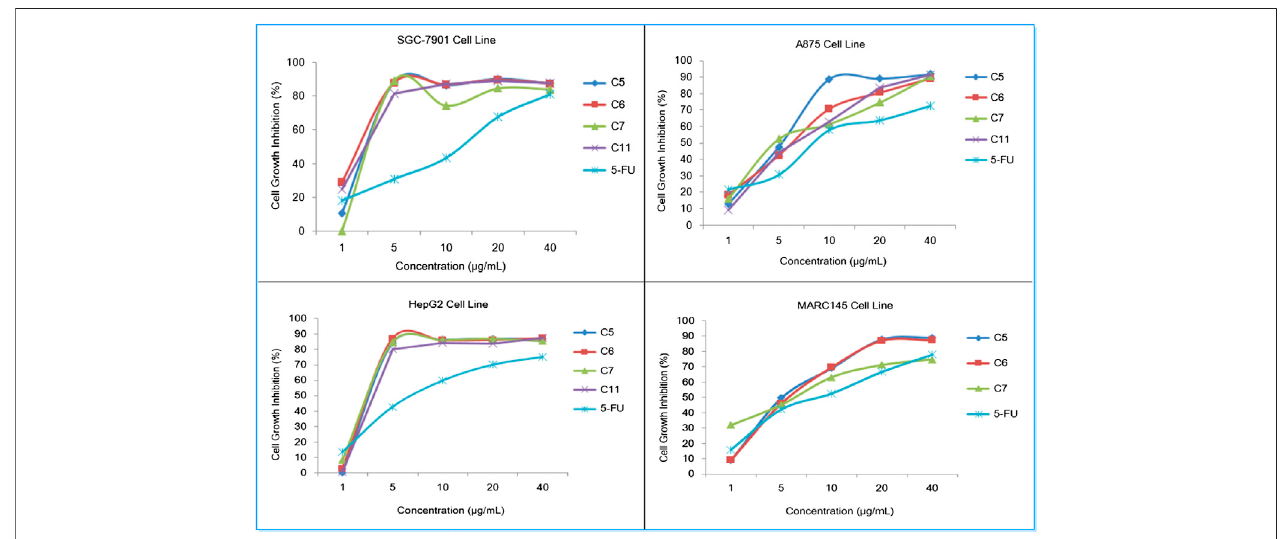
FIGURE 6 | Dose-response analysis of cell growth inhibition activity for compounds C5 , C6 , C7 , and 5-FU (positive control) against SGC-7901 cells (upper left), A875 cells (upper right), HepG2 cells (lower left) and MARC145 cells (lower right).